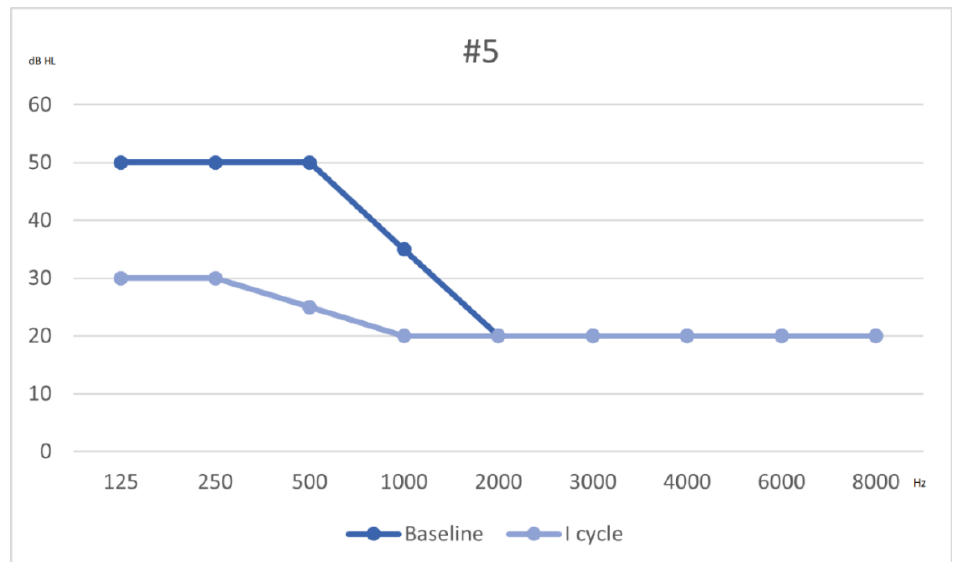
Figure 5. Hearing threshold of the right ear, from baseline to outcome (after 2 cycles of therapy).